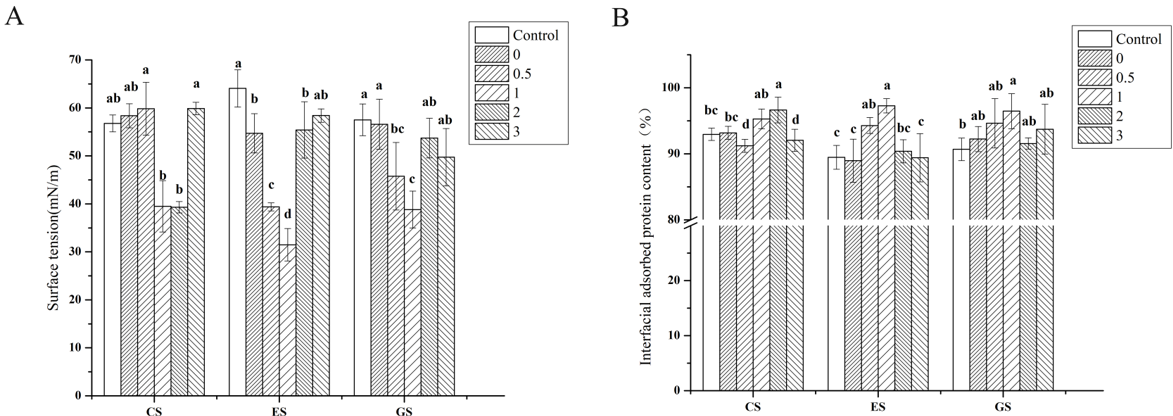
Figure 5. Surface tension of fish gelatin ( A ) and interface adsorption protein of fish gelatin ( B ). Control: raw fish gelatin, 0–3: phosphorylation of fish gelatin at 0, 0.5, 1, 2 and 3 h. Different lowercase letters denote significant differences ( p < 0.05).